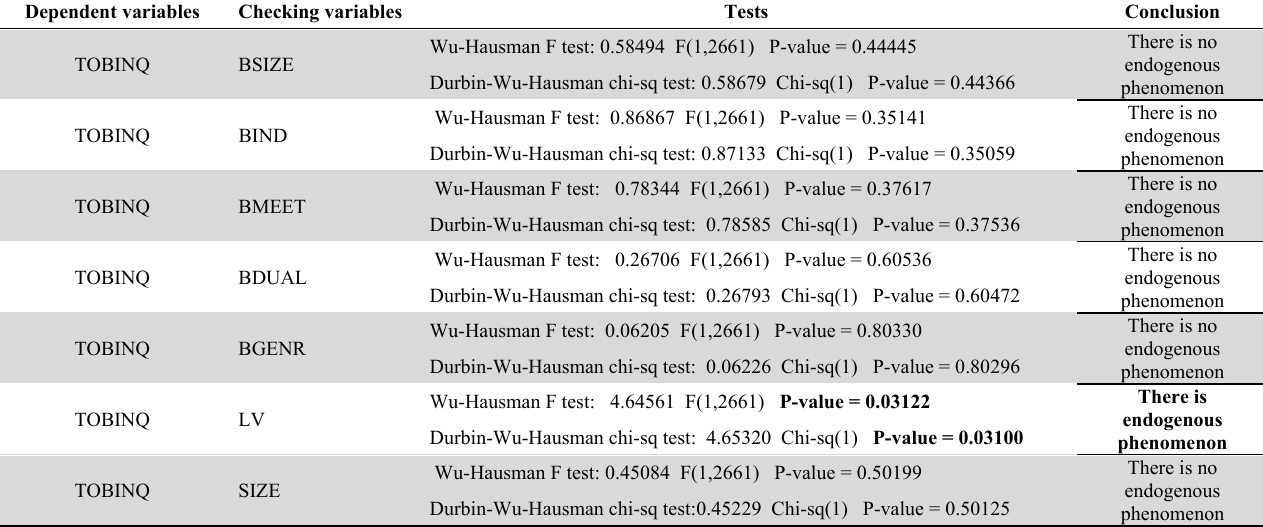
Results of endogeneity